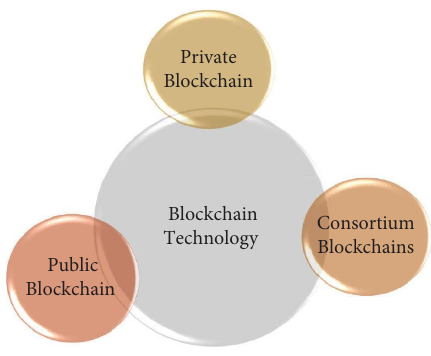
Figure 2: Summary of